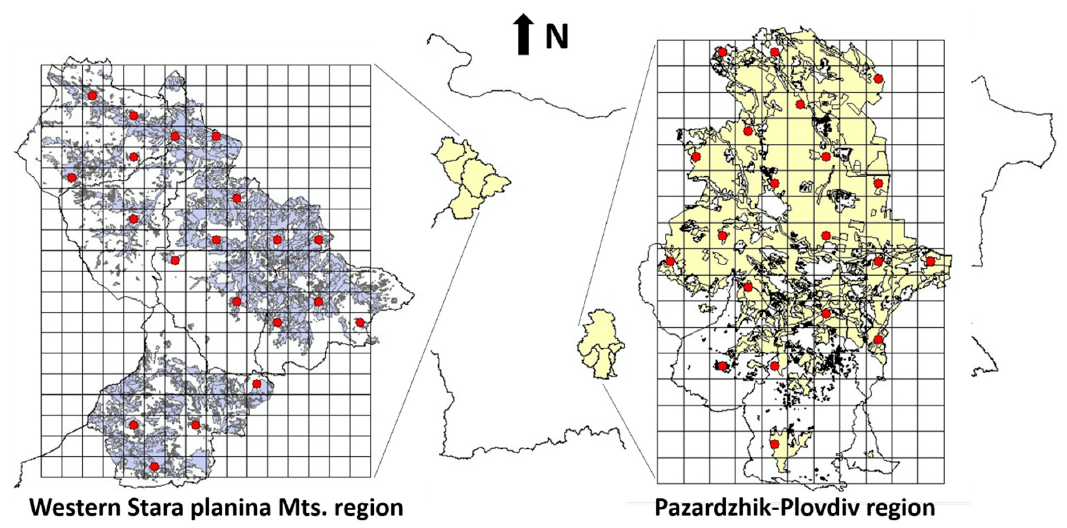
Figure 2. Maps of the two regions of study together with the land use types studied (red dots).